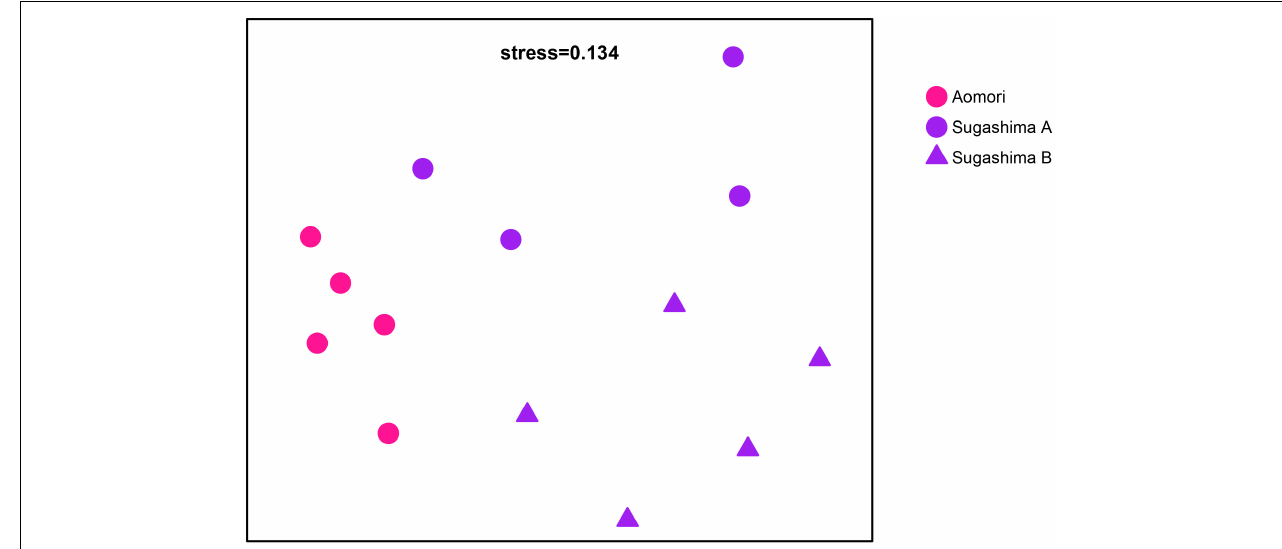
FIGURE 4 | Non-metric MDS with the 14 samples from Japan (five from Aomori, four from Sugashima clade A, and five from Sugashima clade B). Each color represents a locality. Dots correspond to clade A samples and triangles to clade B samples.